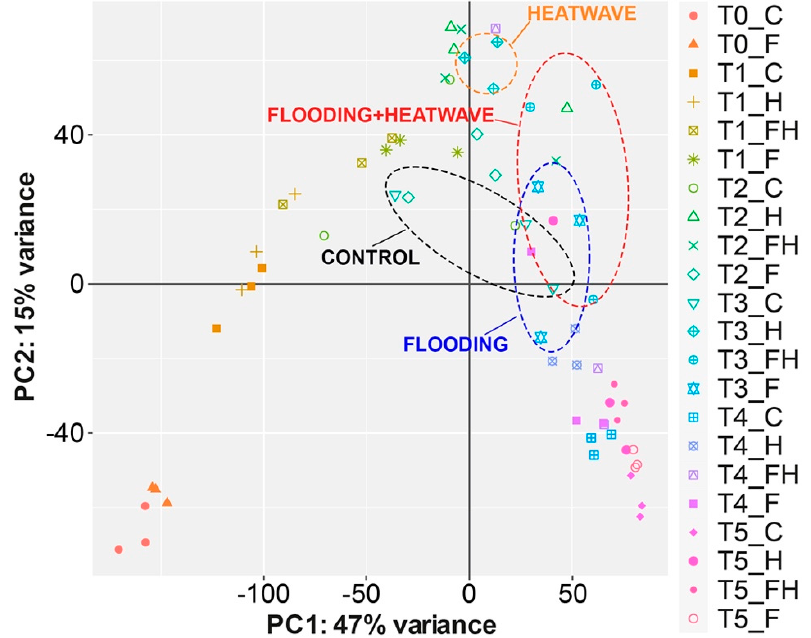
Figure 4. Principal component analysis of the samples built using the 5000 most variable genes. The ellipses show the most relevant group samples at T3 when the stress is maximum. The legend on the right provides indications of the colors and symbols used in the chart for each sample. Samples are named according to the timepoint and treatment (C, control; F, flooded; H, heatwave; FH, flooded plus heatwave).